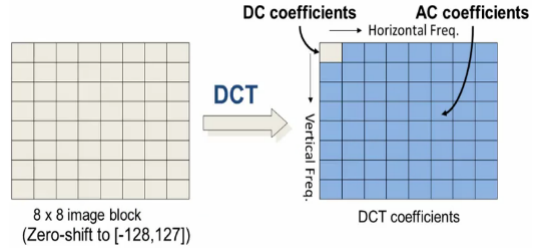
Figure 3: An illustration of DCT block of pixels [31]